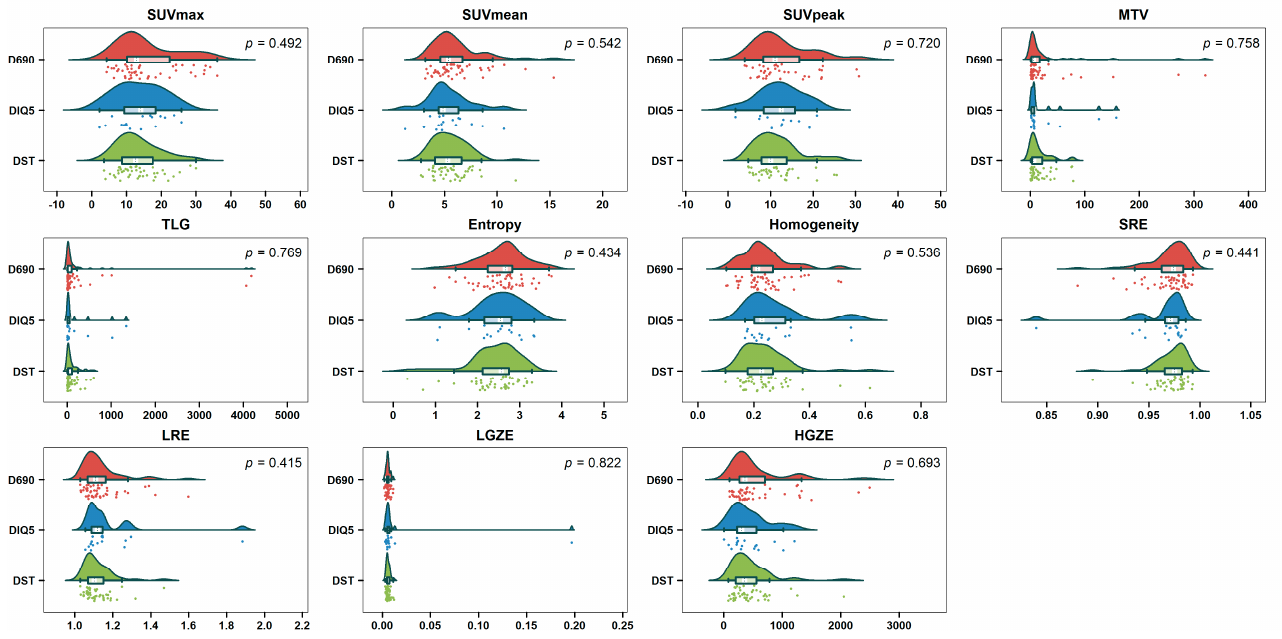
Figure 4. Raincloud plots of metabolic, volumetric and textural features from the three types of PET/CT system (Discovery 690 (D690); Discovery IQ 5 rings (DIQ5); Discovery ST (DST)) before harmonization.